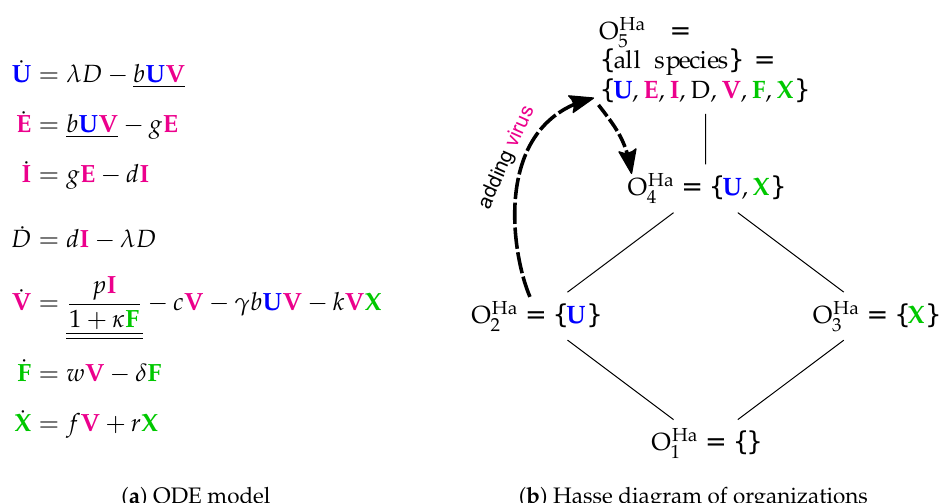
Figure 7. The Handel model [24] with seven variables: uninfected cells ( U ), latently infected cells ( E ), productively infected cells ( I ), dead cells ( D ), free viruses ( V ), innate immune response ( F ) and adaptive immune response ( X ). The dotted arrows denote the projection of the dynamics shown in Figure